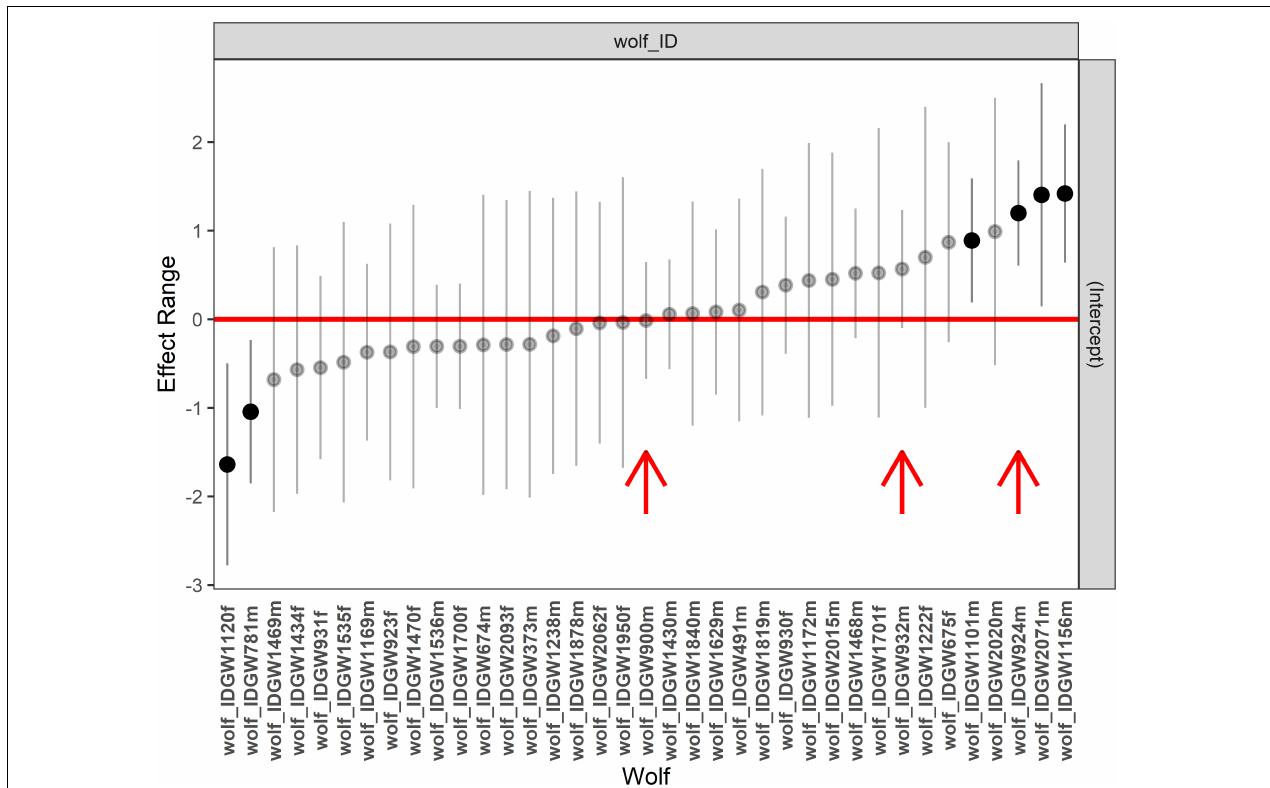
FIGURE 4 | Estimated random effect (of each individual wolf) of the model describing the daily livestock depredation rates by individual wolves in Jutland peninsula (landscape and season as fixed effects). The red arrows indicate the three male siblings that contributed 45% of all livestock attacks. Mean estimates are shown as dots, and 95% confidence intervals as bars. Intervals that do not include zero are in